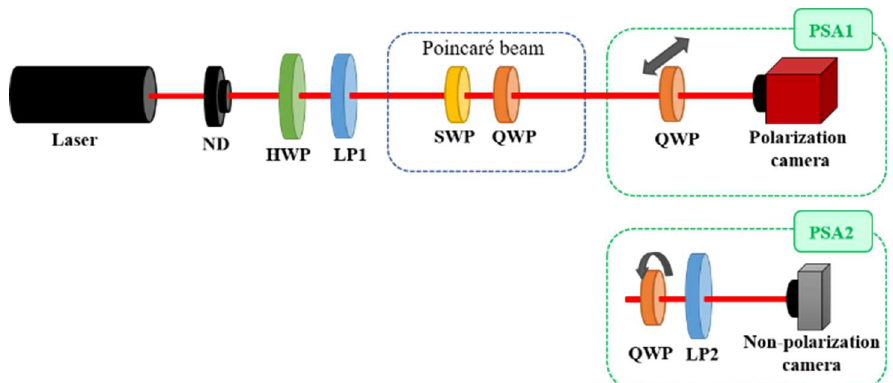
Figure 2: Schematic representation of polarisation distribution measurement in Poincaré beams. The laser beams were analysed with two different polarisation state analysers, PSA1 with a polarisation camera or PSA2 with a non-polarisation camera (Laser: He-Ne 632,8 nm, ND: neutral density filter 2.0, HWP: half-wave plate, LP1: linear polariser, LP2: linear polariser, SWP: structured half-wave plate, QWP: quarter-wave plate)